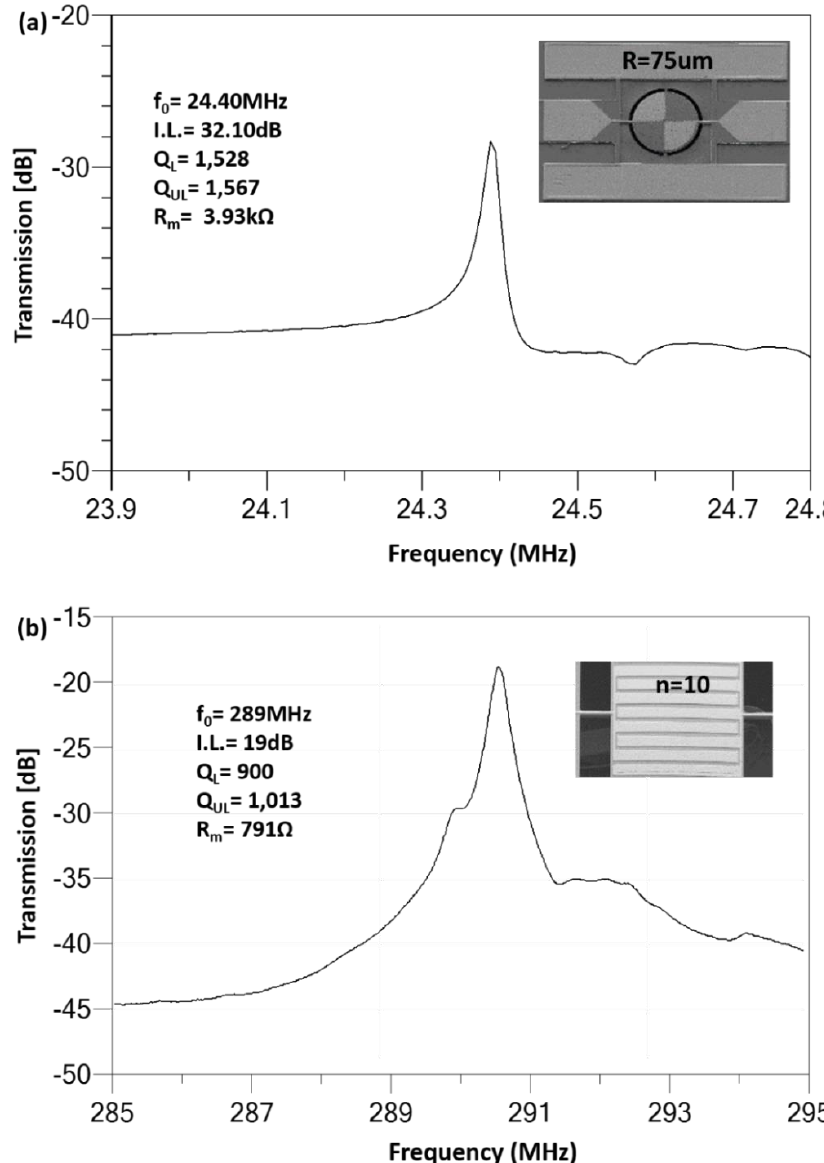
Figure 2. Measured frequency characteristics of two designs of thin-film piezoelectric on silicon (TPoS) resonators by newly developed TPoSCRE process.